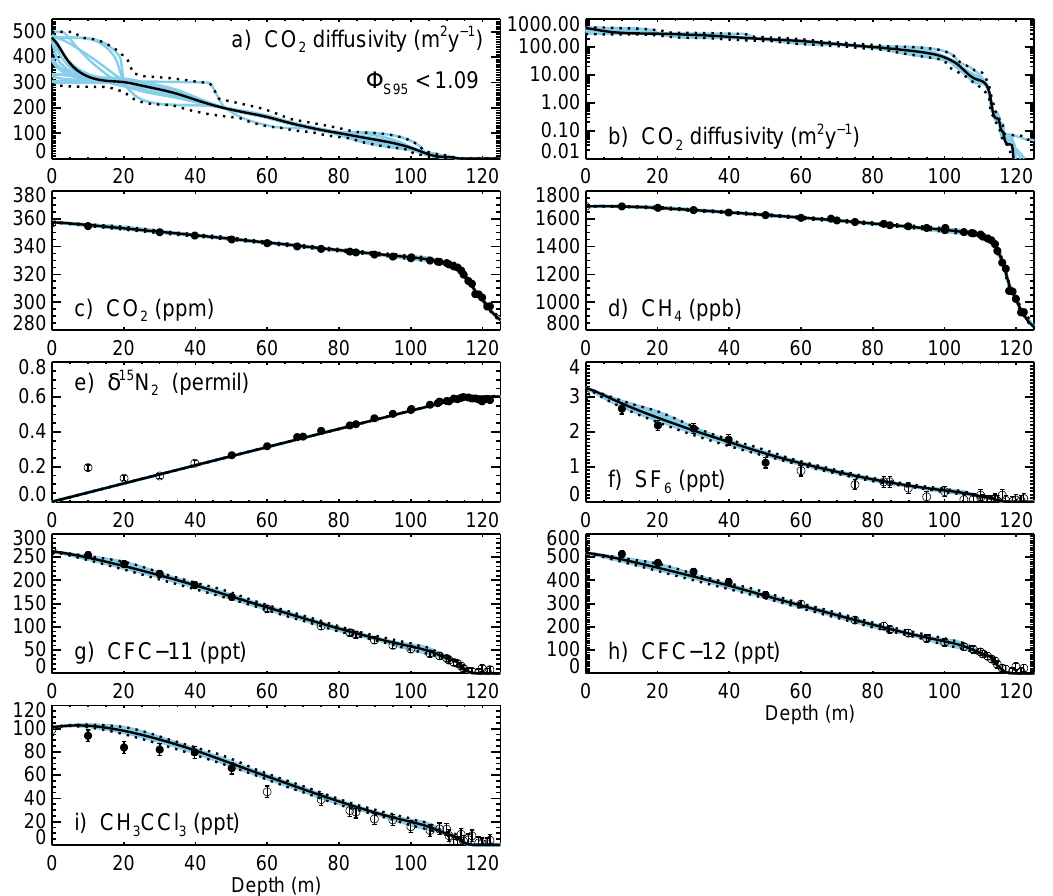
Fig. 11. Diffusivity and tracers at South Pole 1995 for 8 S95 < 1 . 09. Solid circles show observations used for calibration, open circles show additional measurements that were not used for